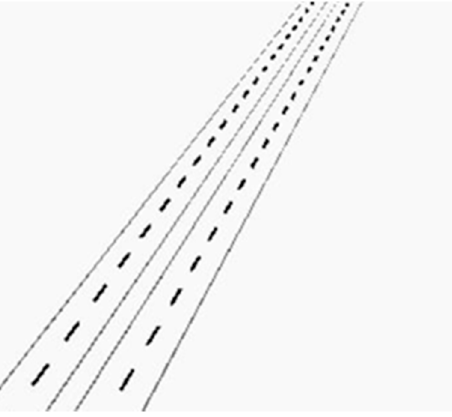
Figure 11. Road markings as designed in Dynamo.